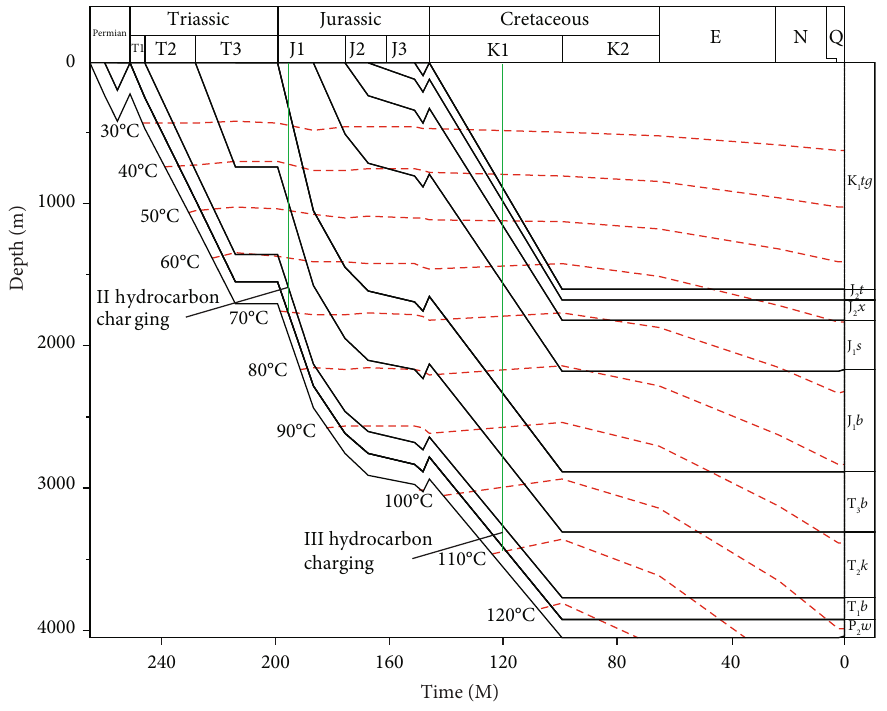
Figure 3: Burial and thermal chart of the well M13, modi fi ed after Pan et al.